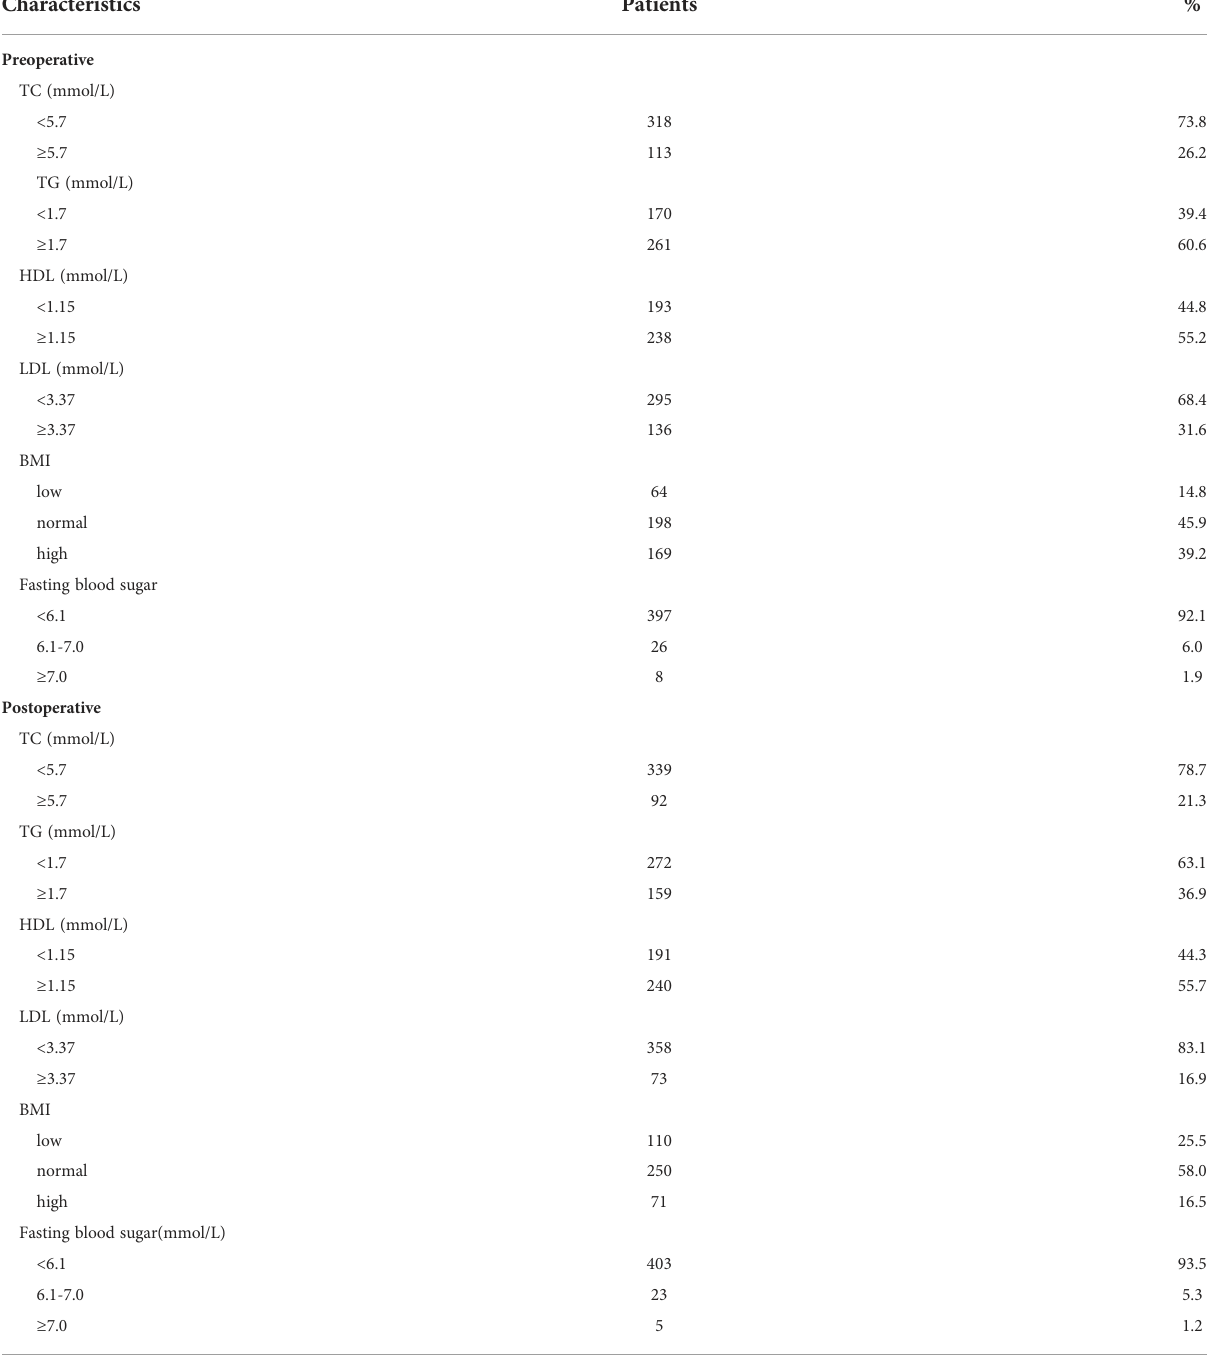
TABLE 2 characteristics of lipid pro fi le, BMI and fasting blood sugar in the 431 gastric cancer patients.